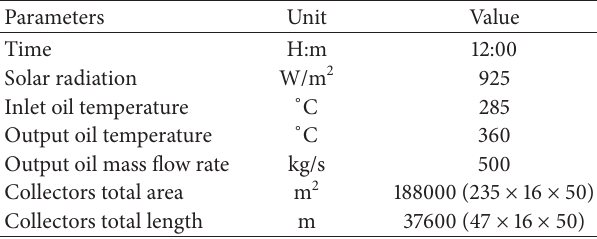
Table 3: Parameters of the base condition.